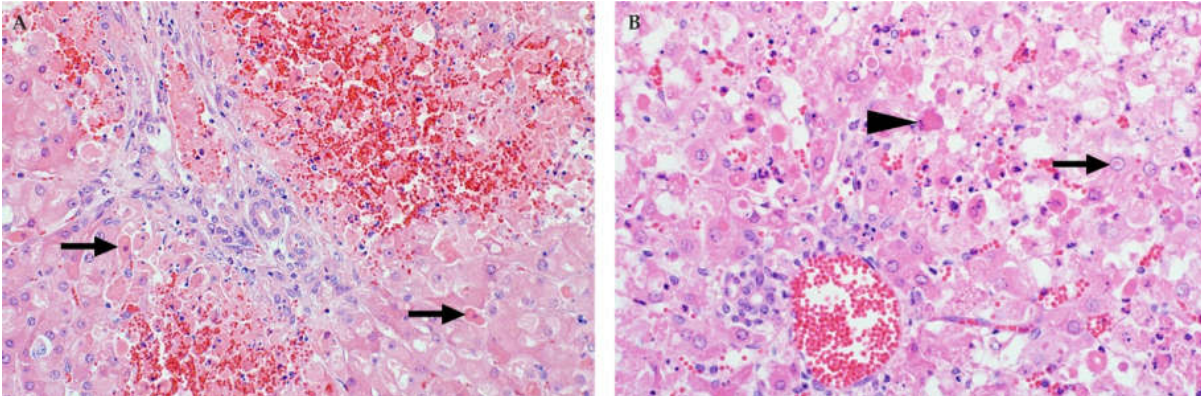
Figure 3. Histopathology of the liver in young lambs naturally infected with RVFV (H&E stain). ( A ) Hepatocytes with features of apoptosis (arrows), characterized by disassociation of cells, hypereosinophilic cytoplasm and pyknosis or karyorrhexis, mag 400×. ( B ) Diffuse necrosis of hepatocytes, filamentous eosinophilic intranuclear inclusions (arrow), and late apoptotic bodies (arrowhead), magnification 600×.